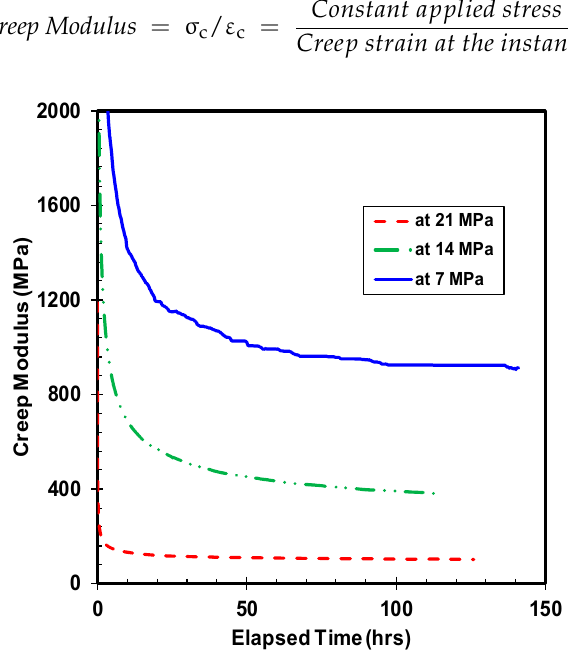
Figure 5. Creep modulus under different loads at ambient temperature.